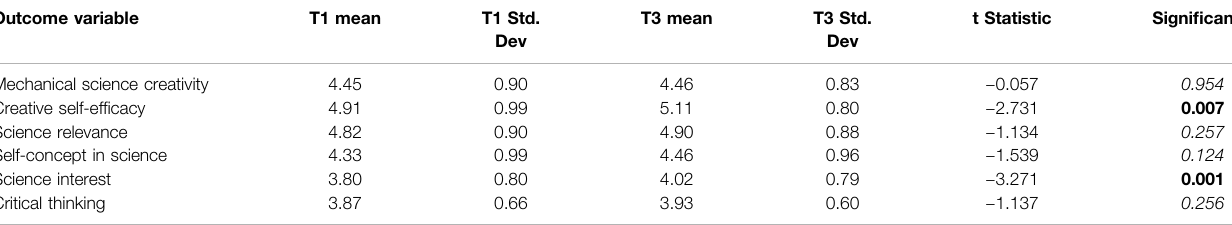
TABLE 2 | Aggregate T1 to T3 outcome variable means independent samples t -Test. Outcome variable